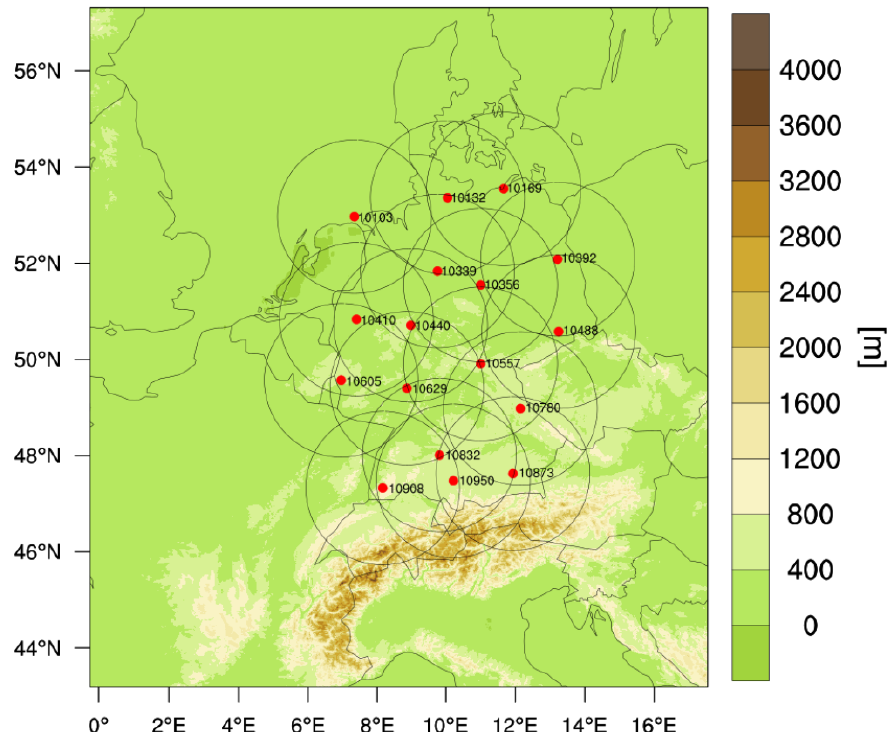
Figure 1. Illustration of the ICON-D2 domain with the orography and of the radar network of the DWD (each station is denoted by a red bullet and the station number; the scanning range is denoted by a